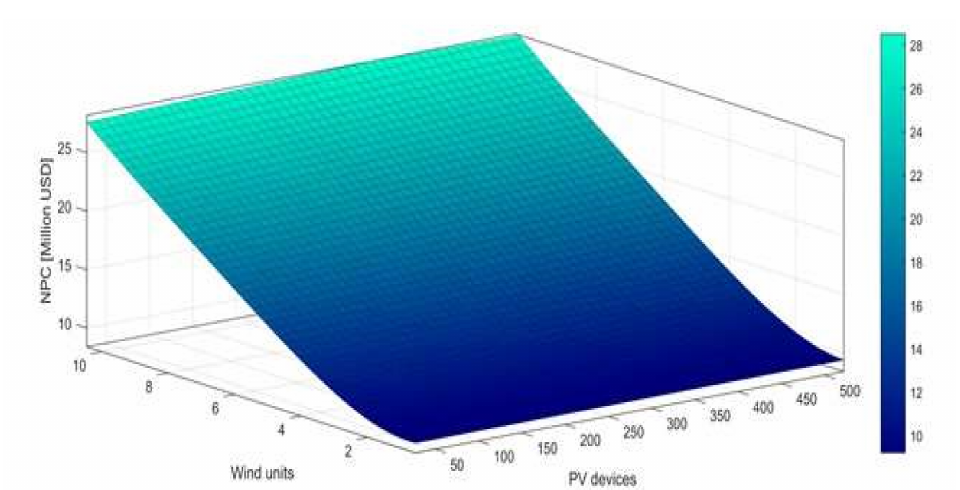
Figure 12. Polynomial regression for NPC (Rancho Grande).